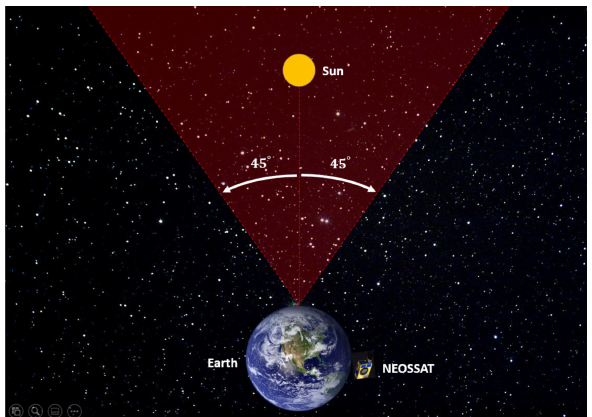
image cleaning technique developed by (Abbasi et al., Figure 1. NEOSSat Geosynchronous object observing geometry with Continuous Viewing Zone (CVZ) shown, inspired from (Scott, Thorsteinson, 2018) NEOSSat’s raw data is downloaded, processed, and archived at the Canadian Space Agency (CSA) in FITS format (Canadian Space Agency, 2019). The raw astronomy images are copied automatically to CSA’s Open Data archive, publicly accessible from: